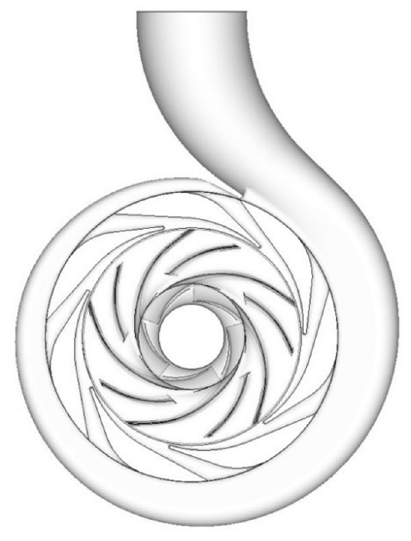
Figure 1. Structural diagram of the model and its structural explosion diagram.